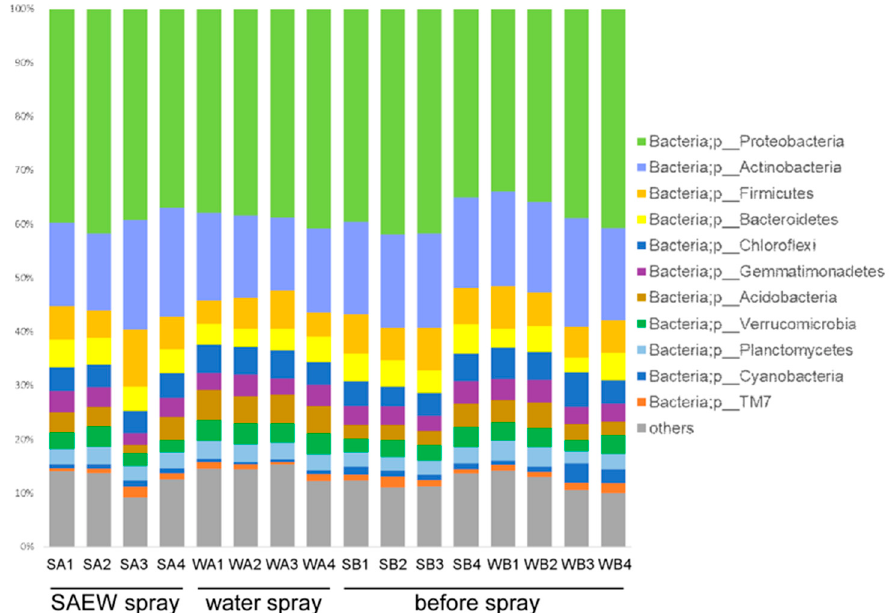
Figure 6. Taxonomic analysis of bacteria in the greenhouse soil. Soil samples were taken from SB; area A before spray, WB; area B before spray, SA; area A after SAEW spray, WA; area B after tap water spray.